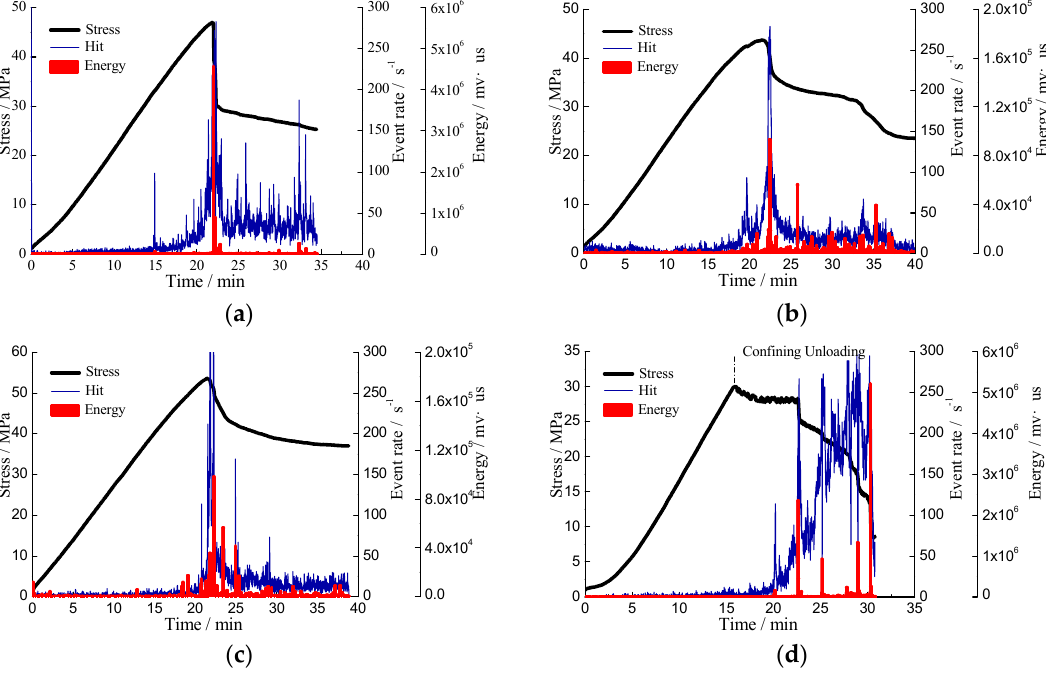
Figure 5. Test results of coal specimens under triaxial compression and confining pressure unloading. ( a ) 5 MPa confining pressure; ( b ) 7.5 MPa confining pressure; ( c ) 10 MPa confining pressure; ( d ) confining pressure unloading. In figures, stress is denoted by thick black curves, AE hit rate by thin blue curve, and AE energy rate by red bar.